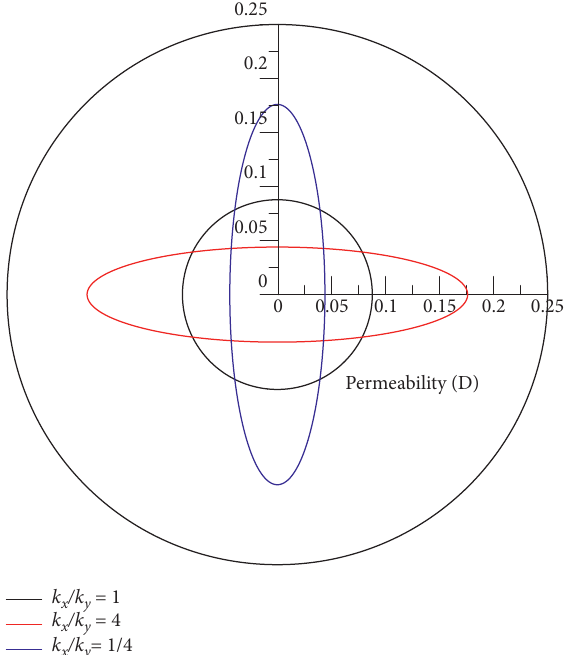
Figure 14: Initial permeability